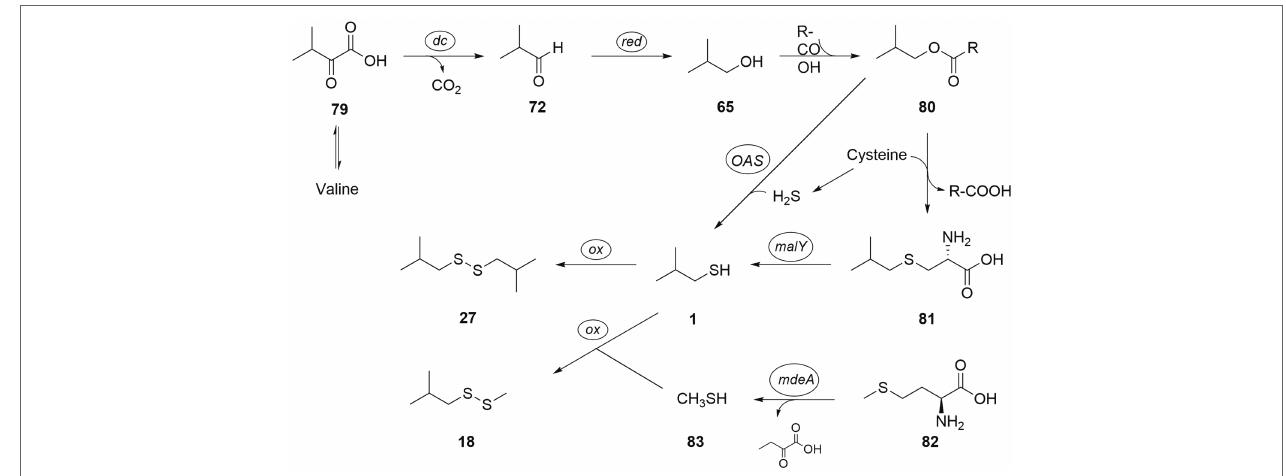
FIGURE 6 | Proposed biosynthetic pathway to thiols and disulfides, exemplified for bis(2-methylpropyl) disulfide (27) and methyl 2-methylpropyl disulfide (18) . tr: transamination; dc: decarboxylation; OAS: O -acetylserine lyase; malY: cystathione lyase; ox: oxidation; and mdeA: methionine γ